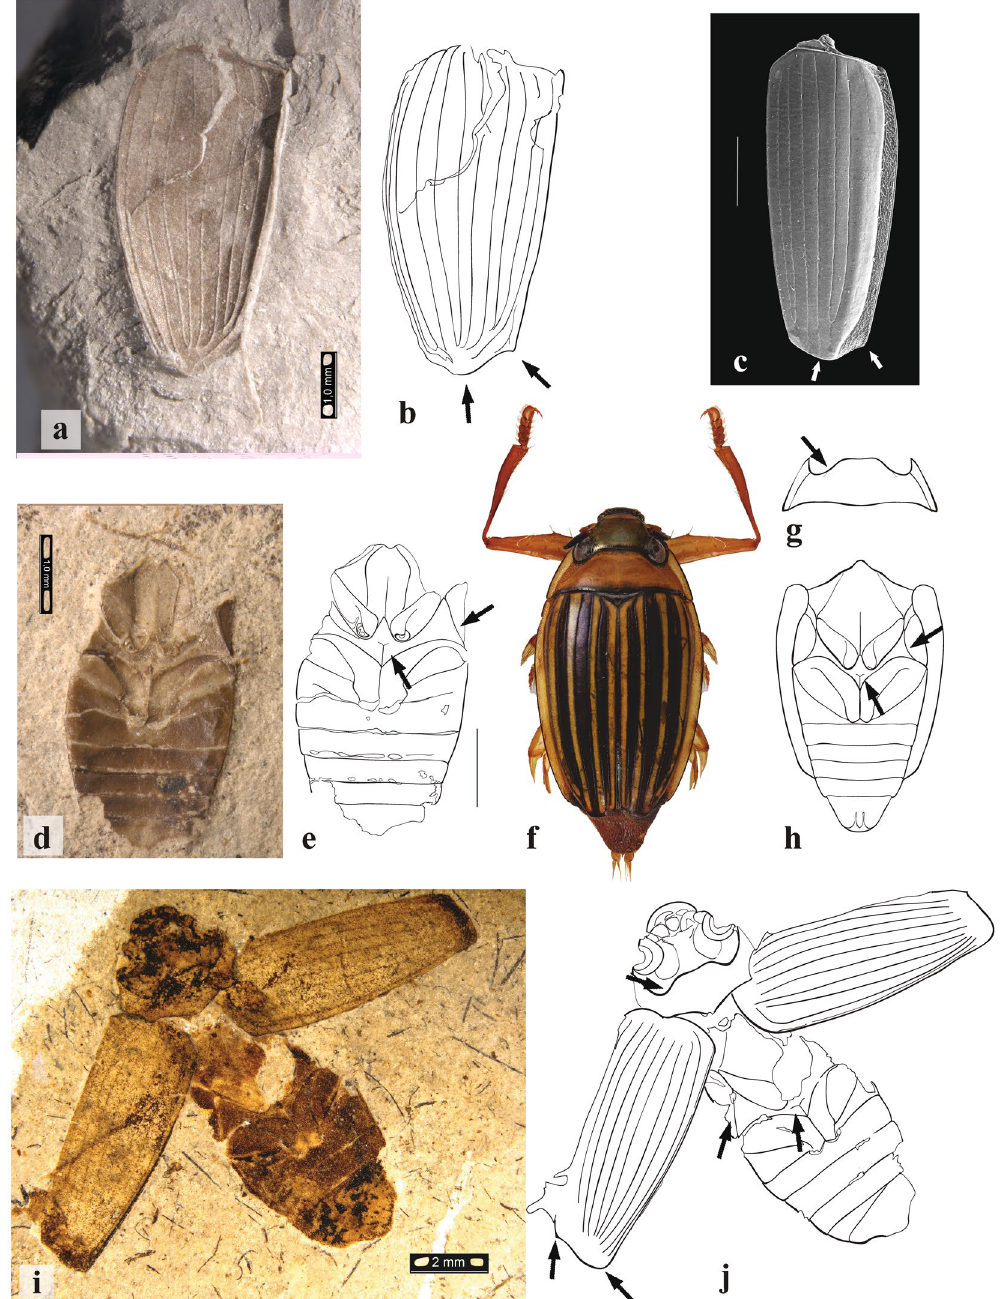
Figure 3. Fossil and extant species of Heterogyrinae. Arrows indicate important morphological features. ( a ) Cretotortor zherichini elytron fossil no. 3149/970; ( b ) line drawing of specimen. ( c ) Heterogyrus milloti elytron SEM, scale bar = 1 mm. ( d ) Baissogyrus savilovi holotype fossil no. 1668/1787, scale bar = 1 mm; ( e ) line drawing of specimen. ( f ) H . milloti dorsal habitus, scale bar 2 mm; ( g ), pronotum of H . milloti ; ( h ), thorax and abdomen of H . milloti ventral view, scale bar = 2 mm. ( i ) Mesogyrus antiquus fossil no. 2997/1846, scale bar = 2 mm; ( j ), line drawing of